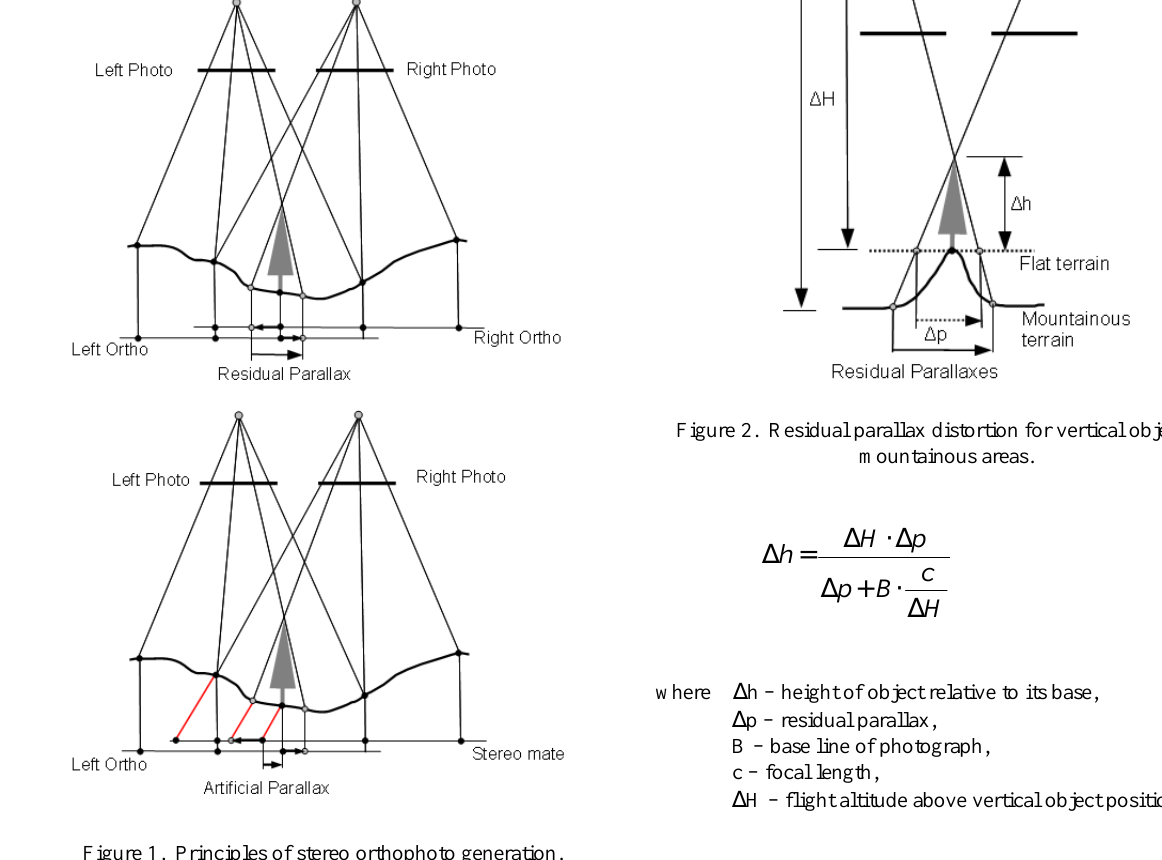
Figure 1. Principles of stereo orthophoto generation.